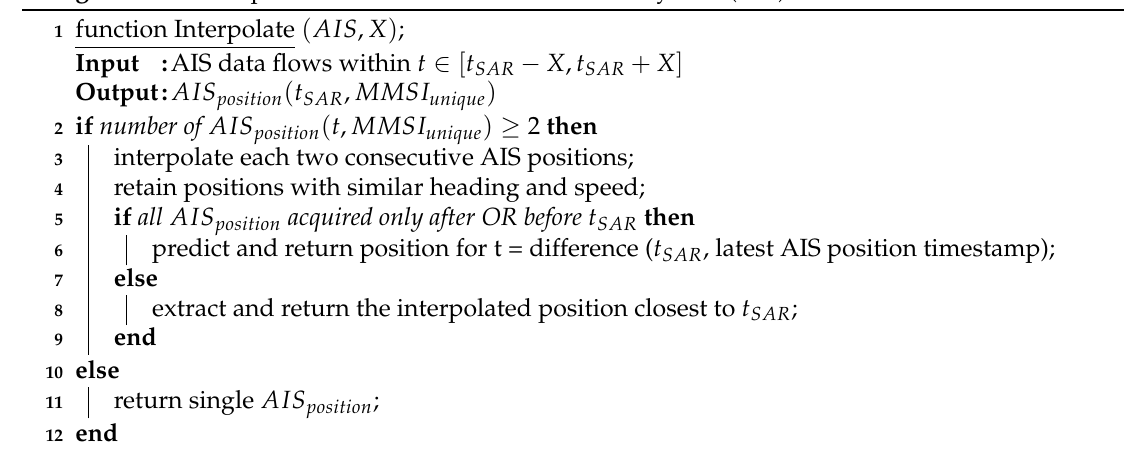
Algorithm 2: Interpolation of automatic identification system (AIS) data